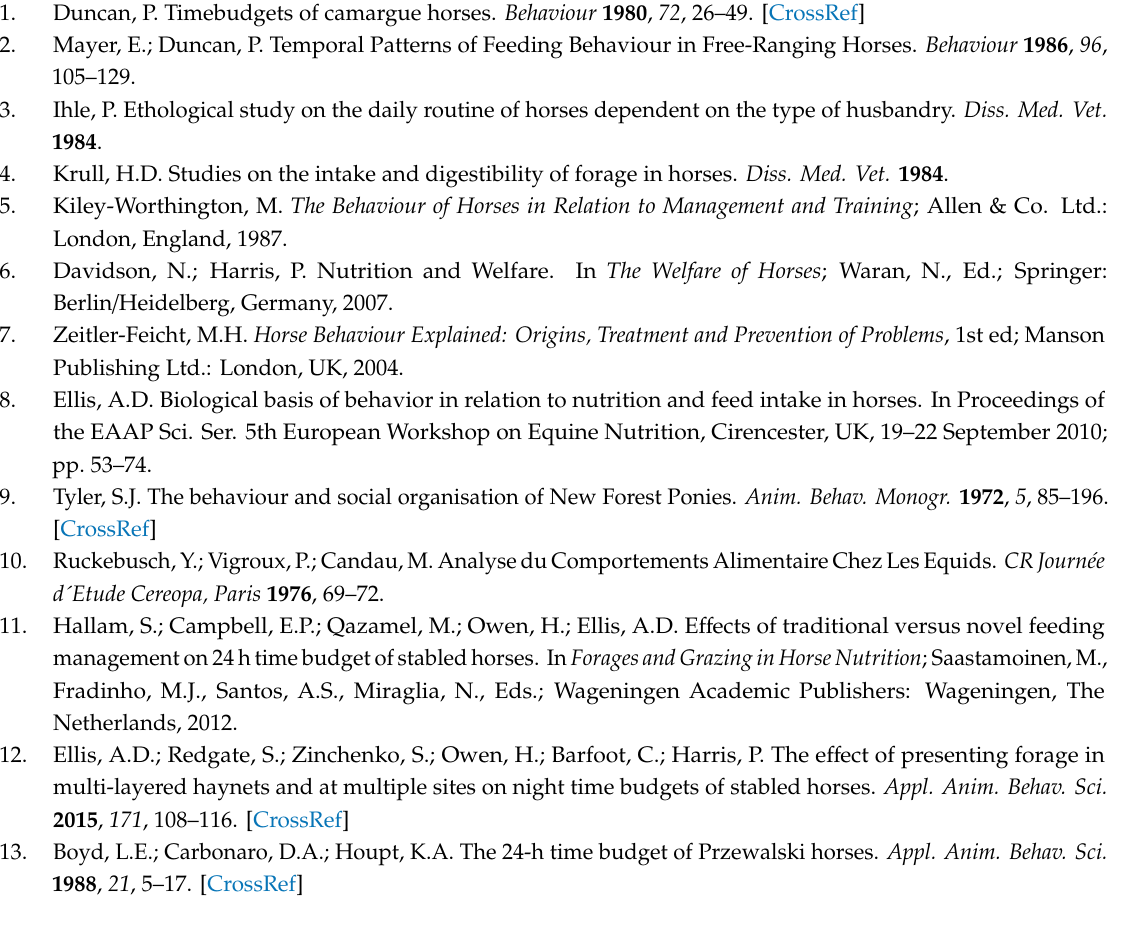
Table S1: Table S1: Total time for finishing the evening meal dependent on farm and bedding; Table S2: Total time for finishing the evening meal dependent on beddingfor feed intake behaviour analysis. Table S3: "Horses on shavings“, which ate up their evening meal within the observation period (Calculation of the duration of the nocturnal feed intake interruption; Table S4: Frequency of pauses, duration of pauses and latency until first feed intake pause during evening meal; Table S5: Number of feed intake pauses dependent on